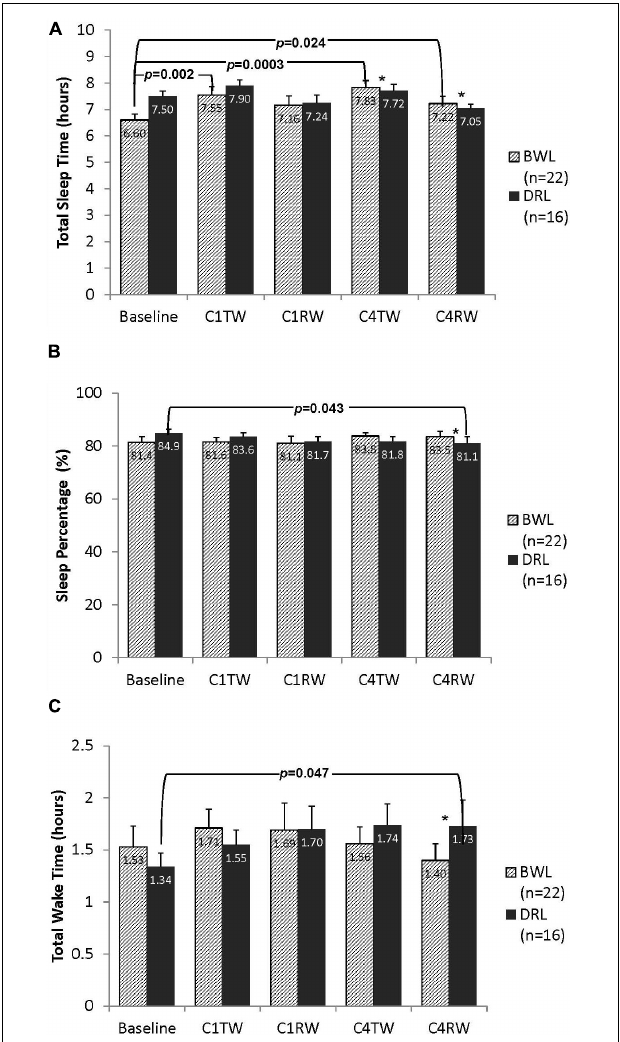
FIGURE 3 | Bar graphs depicting nighttime (A) total sleep time, (B) sleep percentage, and (C) total wake time for both bright white light (BWL) and dim red light (DRL) treatment groups from baseline through the treatment weeks (TW) and recovery weeks (RW) of chemotherapy cycles 1 and 4. With the exception of recovery week of cycle 1 (C1RW), the BWL group demonstrated longer total sleep time (A) compared to baseline. On the other hand, DRL group demonstrated longer total wake time (C) and lower sleep percentage (B) during the recovery week of cycle 4 (C4RW). * p < 0.05 for group-by-time interaction, indicating that compared to DRL group, BWL group had significant longer total sleep time during cycle 4 (both C4TW and C4RW), significant higher sleep percentage and shorter total wake time during